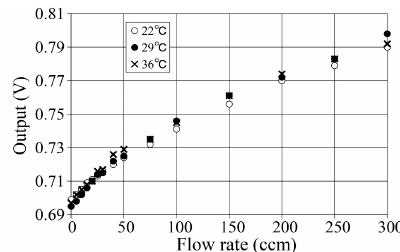
Figure 7. Effect of airflow temperature change on flow rate measurement.